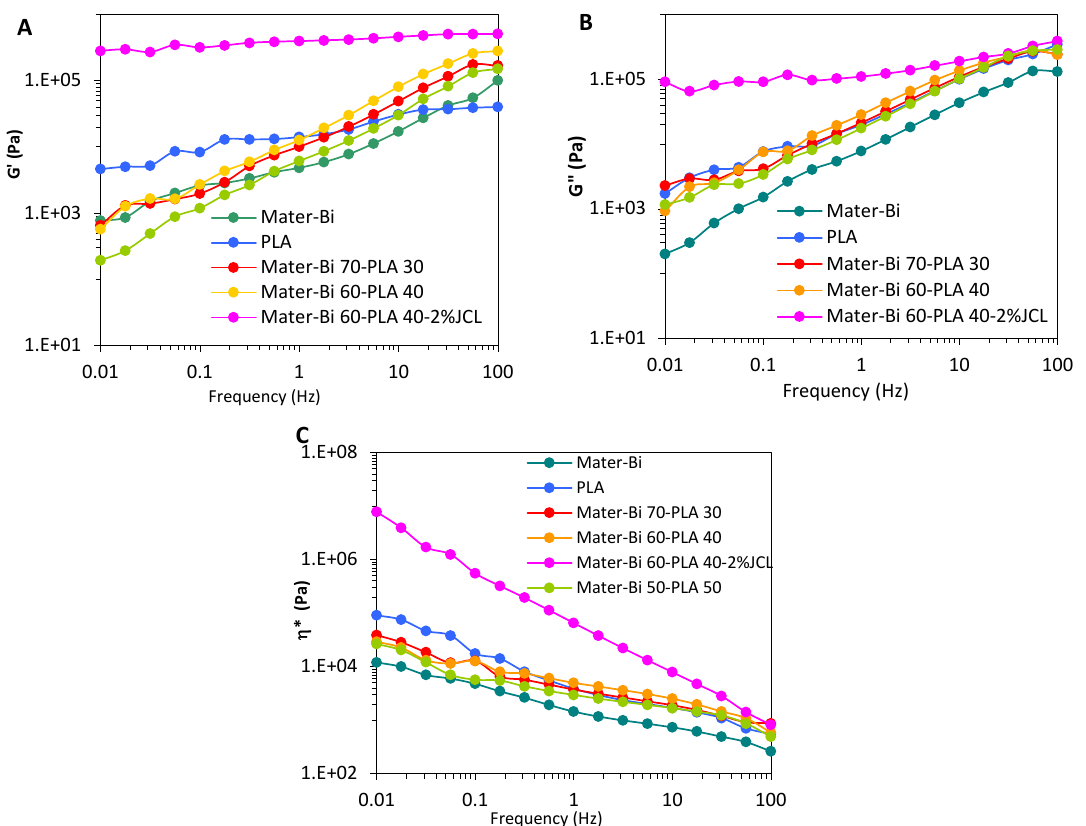
Figure 7. ( A ) Storage modulus (G ′ ), ( B ) loss modulus (G ′′ ), and ( C ) complex viscosity ( η *) versus frequency of Mater ‐ Bi/PLLA blends.